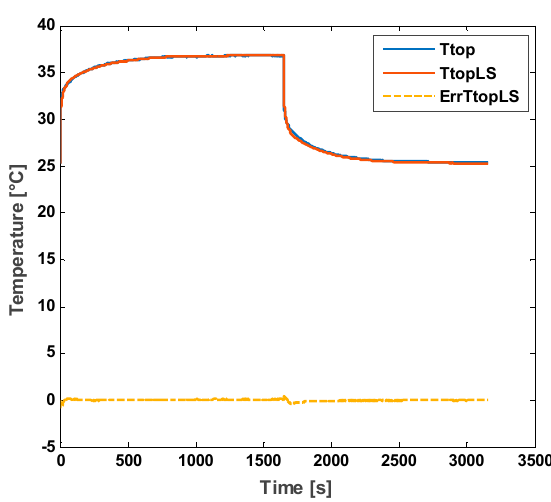
Figure 7. Measured vs. least-squares model temperature 3rd order top transistor active 50A 5 m/s air flowrate.